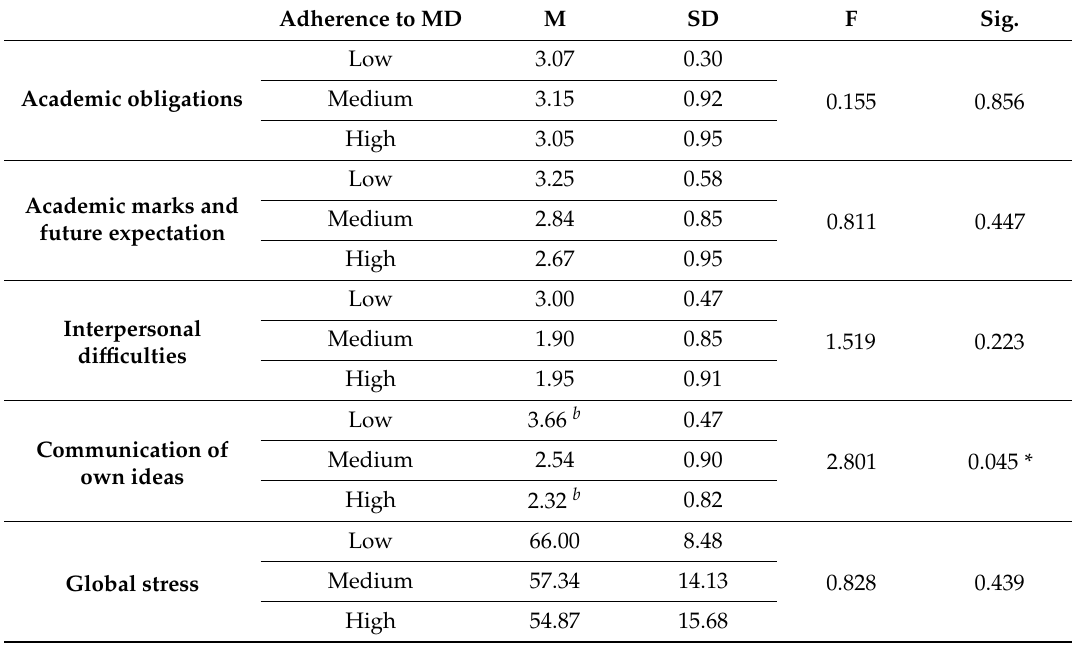
Table 3. Relationship between academic stress and adherence to Mediterranean diet